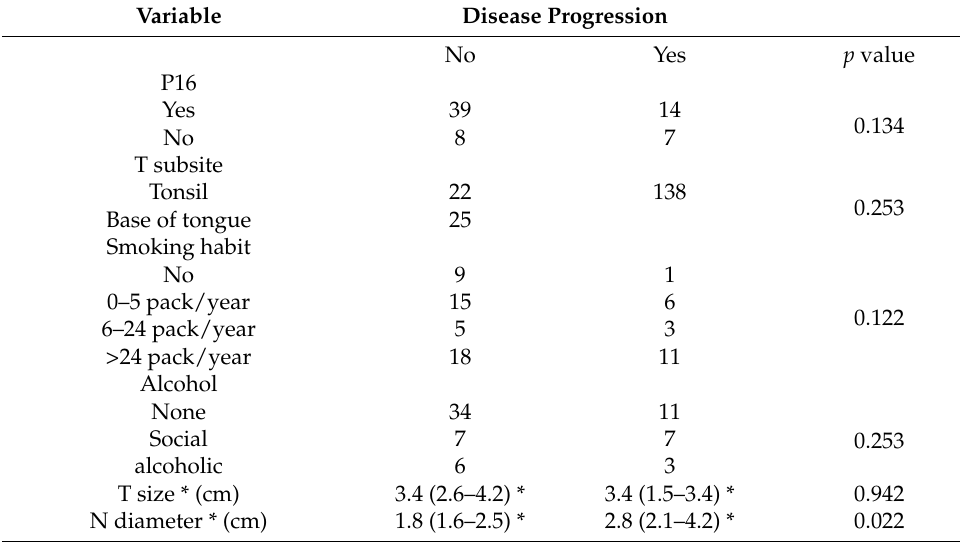
Table 2. Univariate